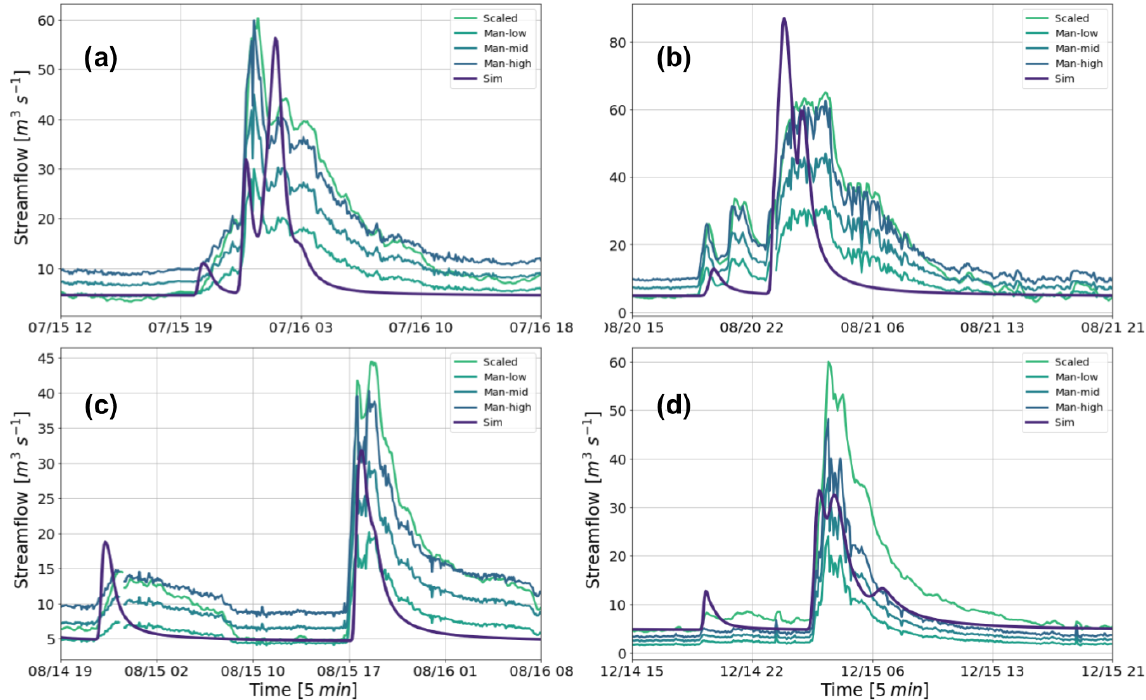
Figure 11. Comparison between TETIS simulations and streamflow estimations from a stage-level station installed on a bridge at the outlet of the basin (see Fig. 2).